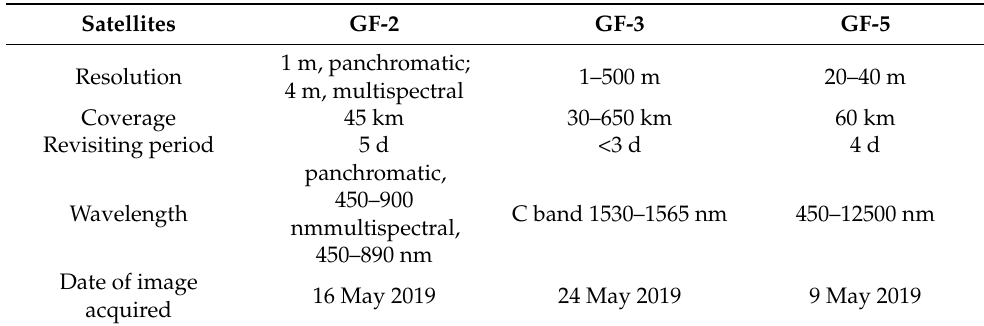
Table 1. Details of the GF-2, GF-3 and